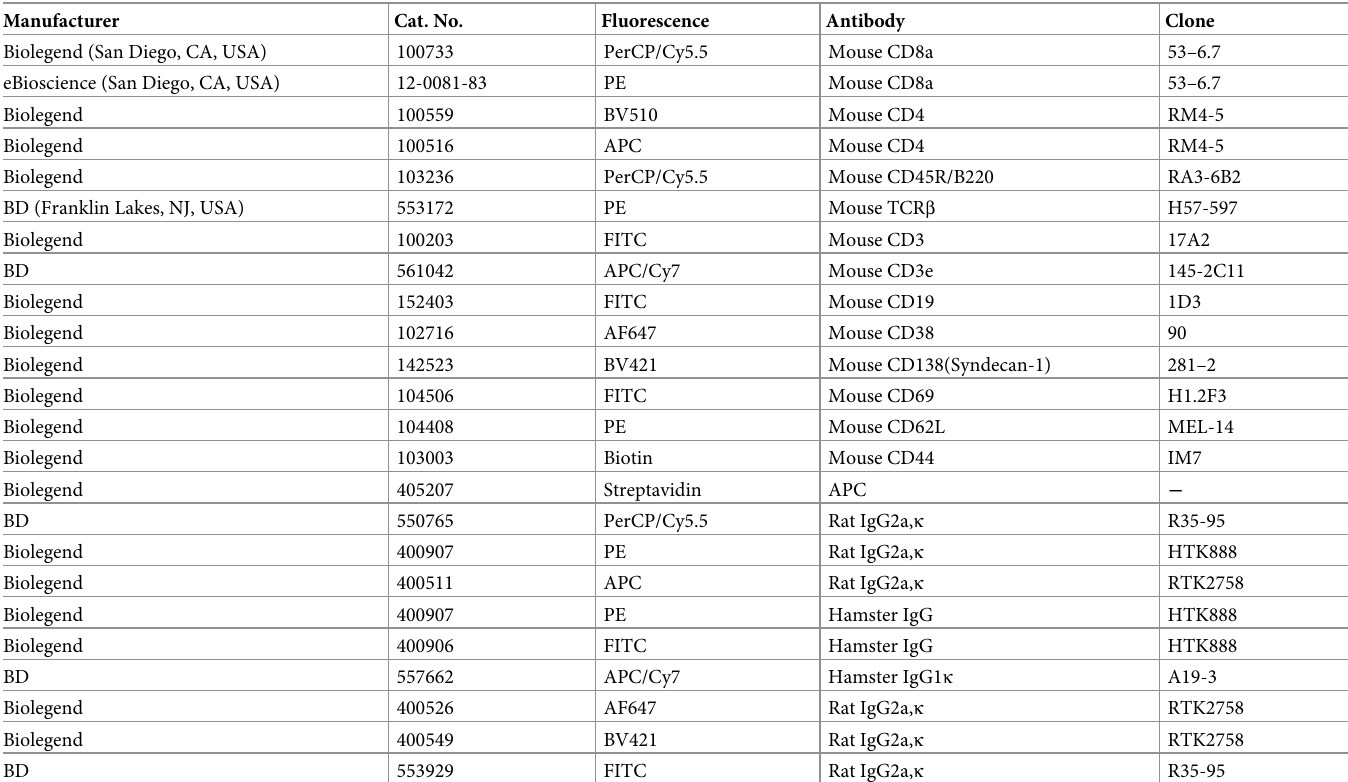
Table 1. Monoclonal antibodies used in flow cytometry in this